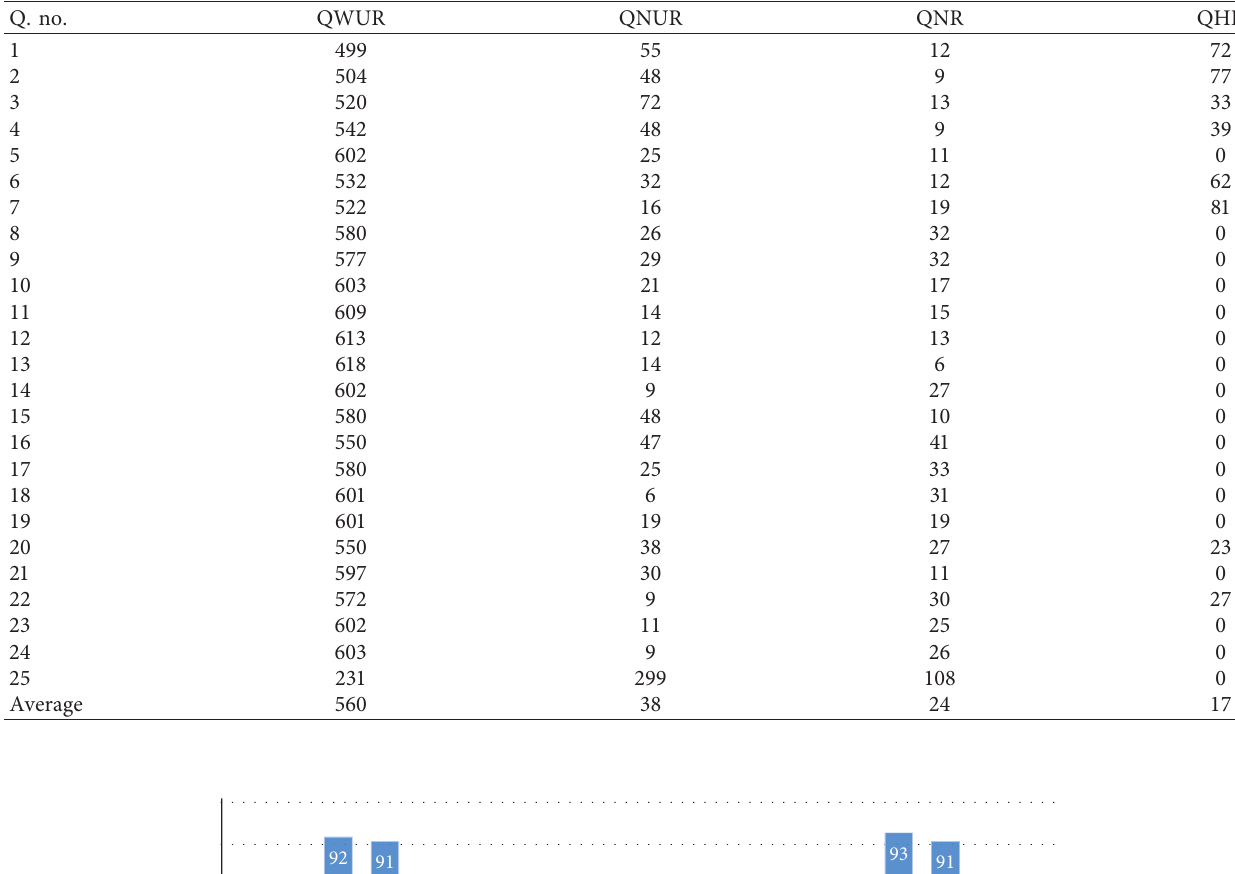
Table 5: Number of responses into QWUR, QNUR, QNR, and QHR.